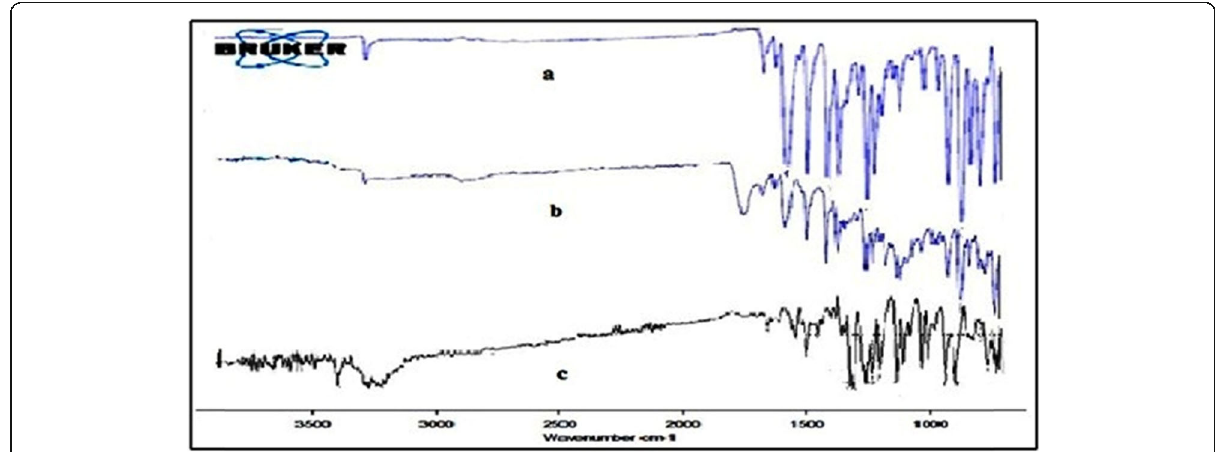
Fig. 1 FTIR spectra of a piroxicam, b physical mixture, and c